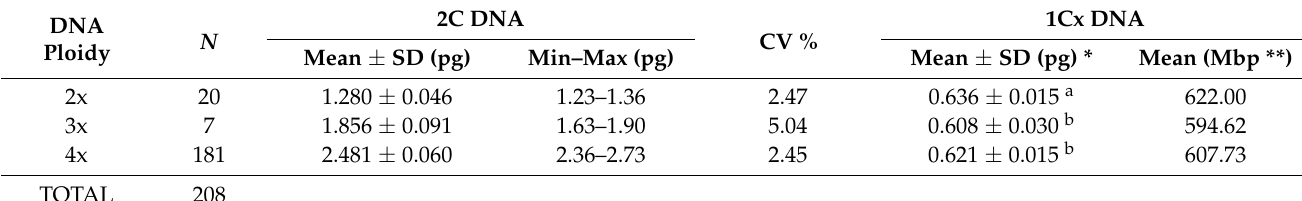
Table 1. Absolute genome size values and ploidy levels of Cotoneaster integerrimus cytotypes. DNA Ploidy